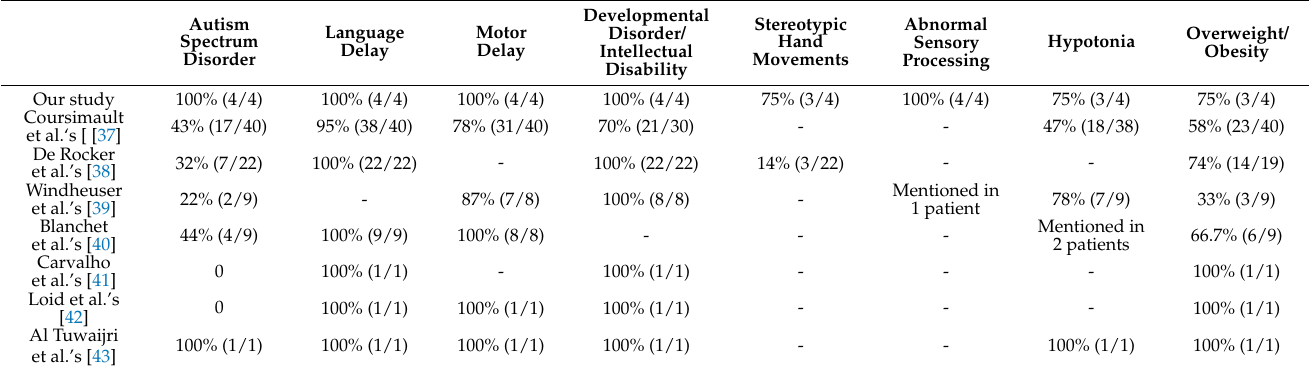
Table 3. Clinical symptoms of MYT1L patients and published